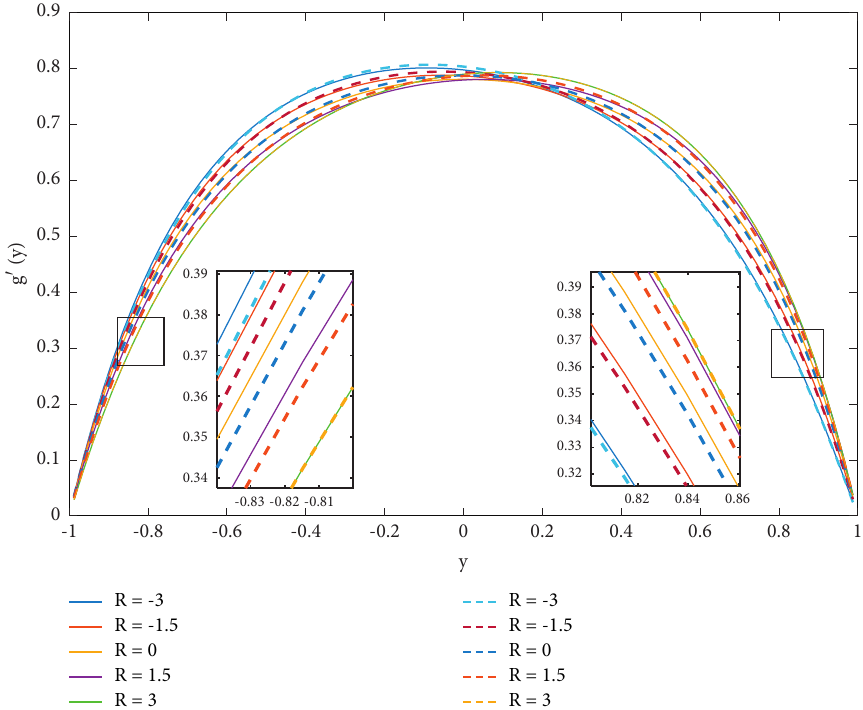
Figure 8: Impact of R over the profile g ( 1 ) ( y ) for SWCNTs (concrete lines) and MWCNTs (dashed lines) via S2HWs for the parameters A ∗ � 0 . 2 , φ � 0 . 1 , α � − 2 . 5.